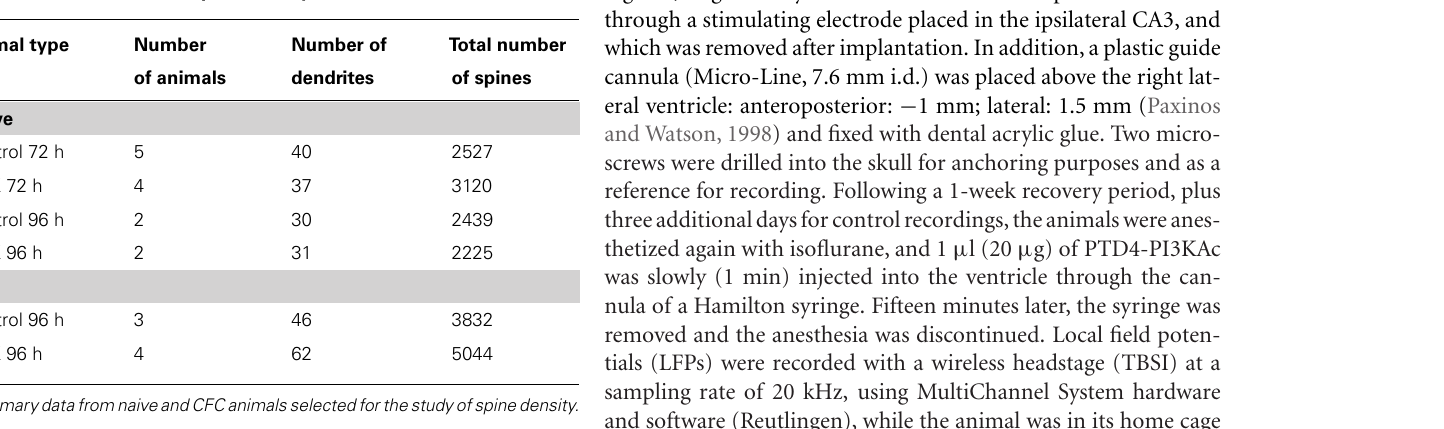
Table 1 | Quantification of spine density in